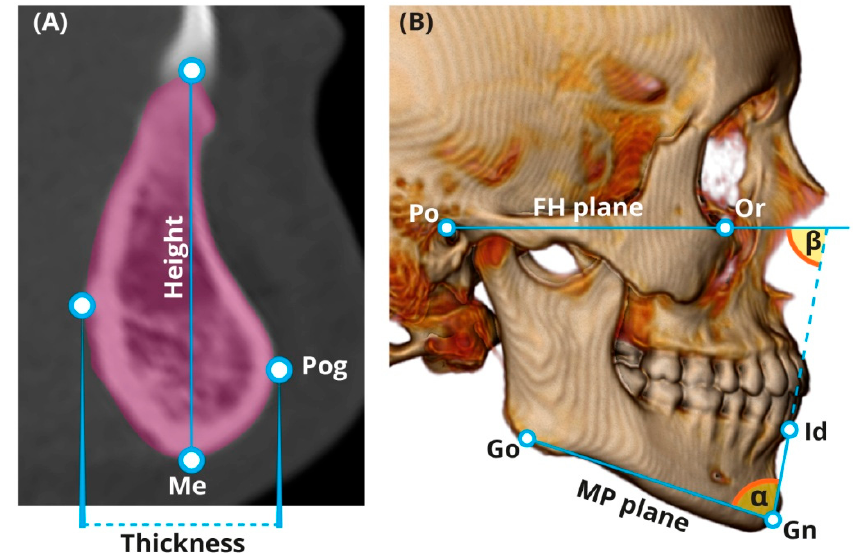
Figure 3. Measurements of symphysis. ( A ) Height, thickness, and CSA (in light pink). ( B ) Symphysis orientation ( β angle) and inclination ( α angle). Me—menton, Pog—pogonion, Po—porion, Or—orbitale, Go—gonion, Id—infradentale, Gn—gnathion, MP—mandibular plane, and FH—Frankfort horizontal. Table 1. Definitions of the chin and the symphysis measurements. Measurement